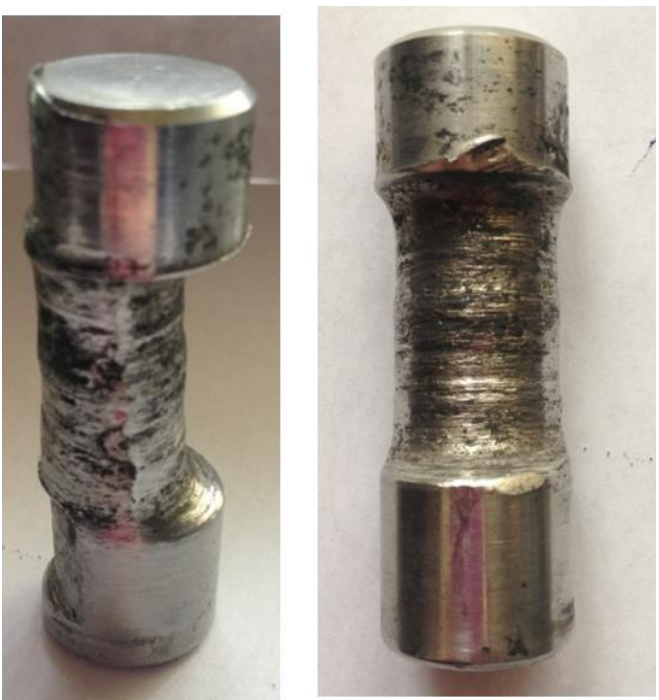
Figure 5. Detail of a worn pin shank (ø 10 mm), by which the chain is attached to the head of the crusher.